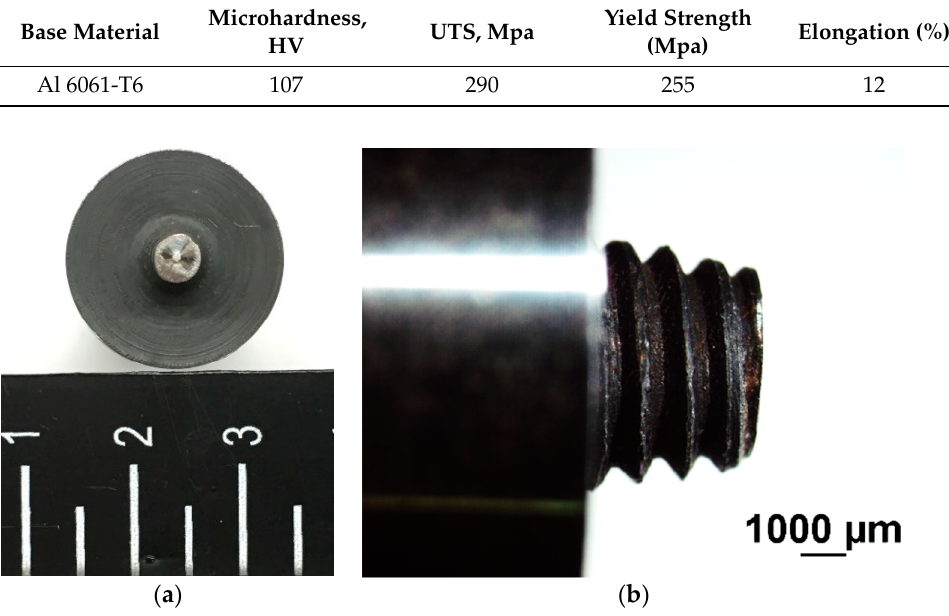
Figure 11. Test plate dimensions (all units in mm). Table 9. Mechanical properties of Al 6061-T6 [121].